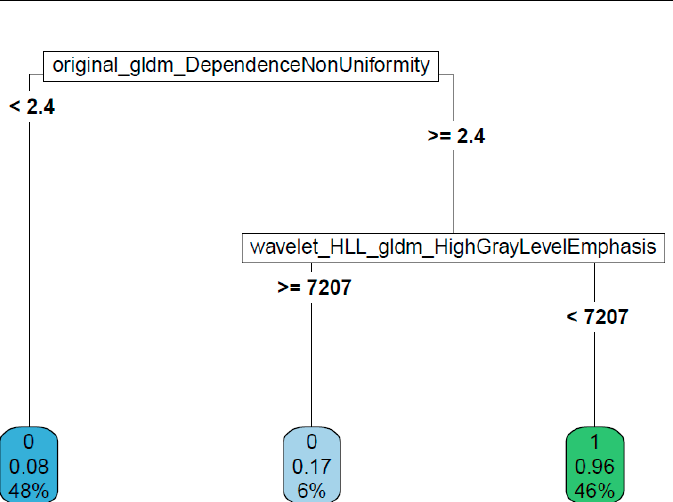
Figure 2. Decisional chart for the prediction of tumor nature from CC images.